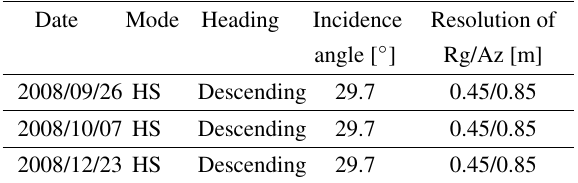
Table 1. Basic parameters of TerraSAR-X images used in this study.